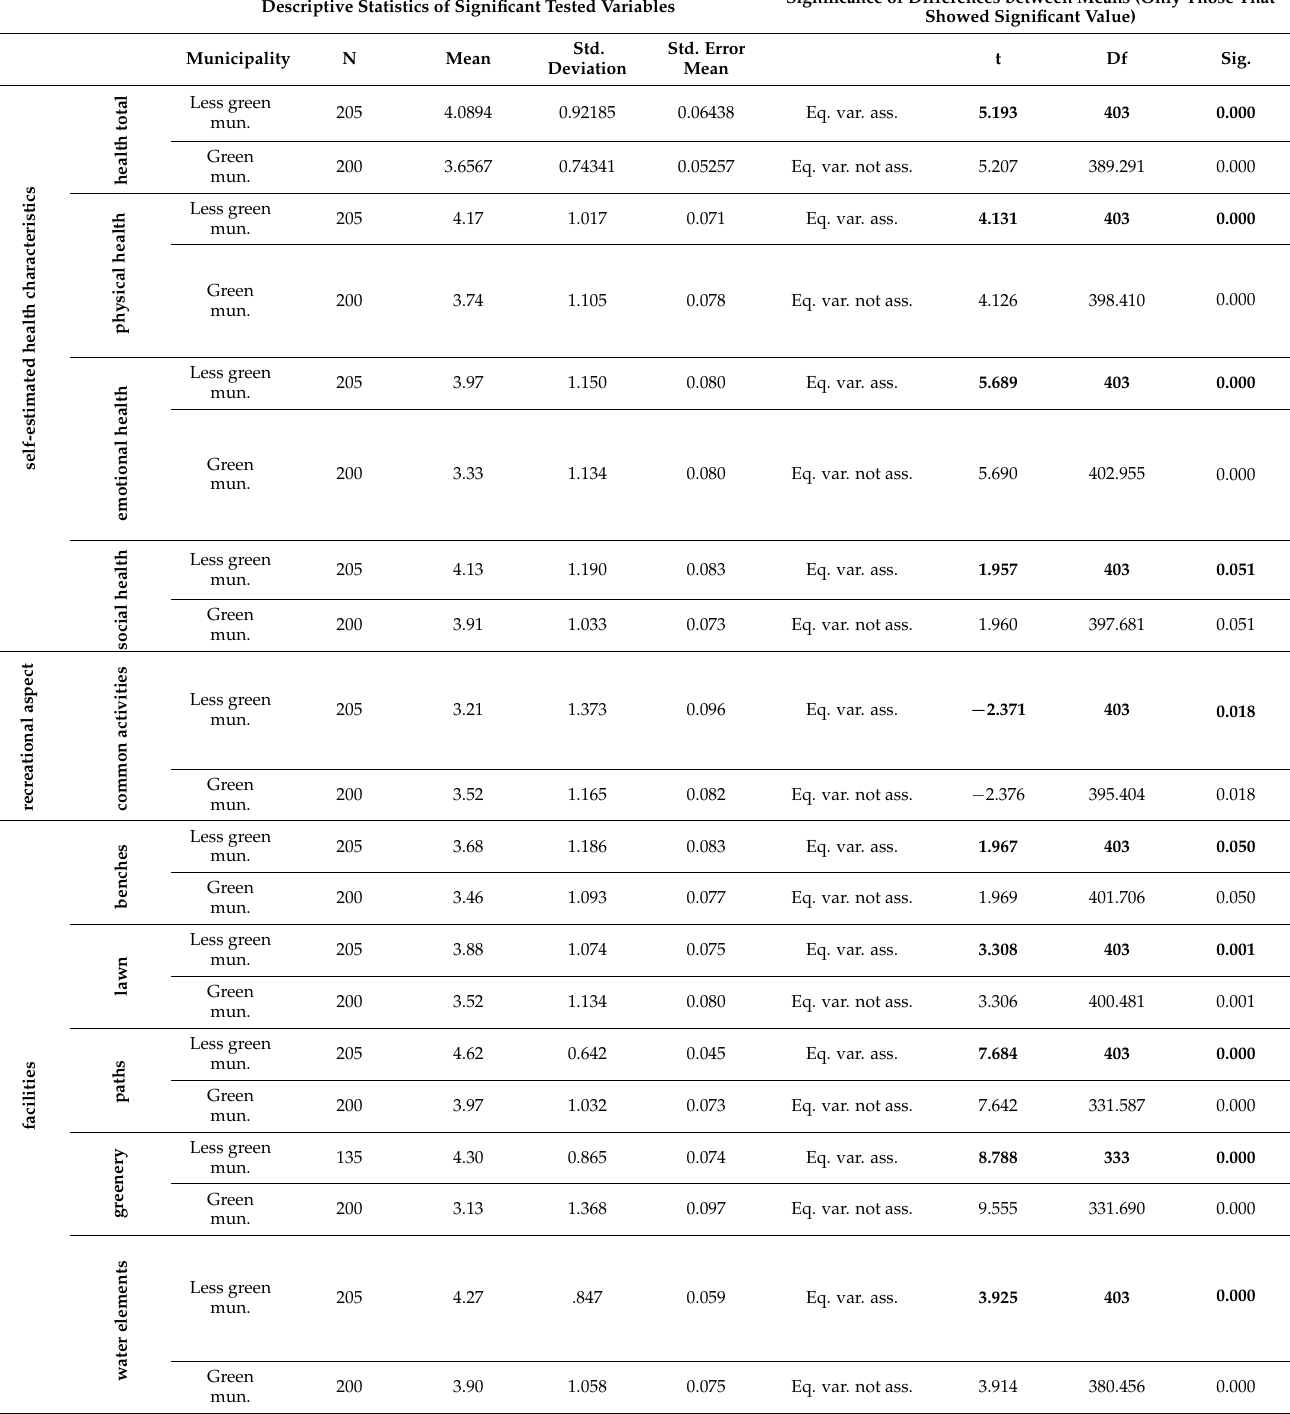
Table 3. Descriptive statistics for significant variables (list of all variables is in Table